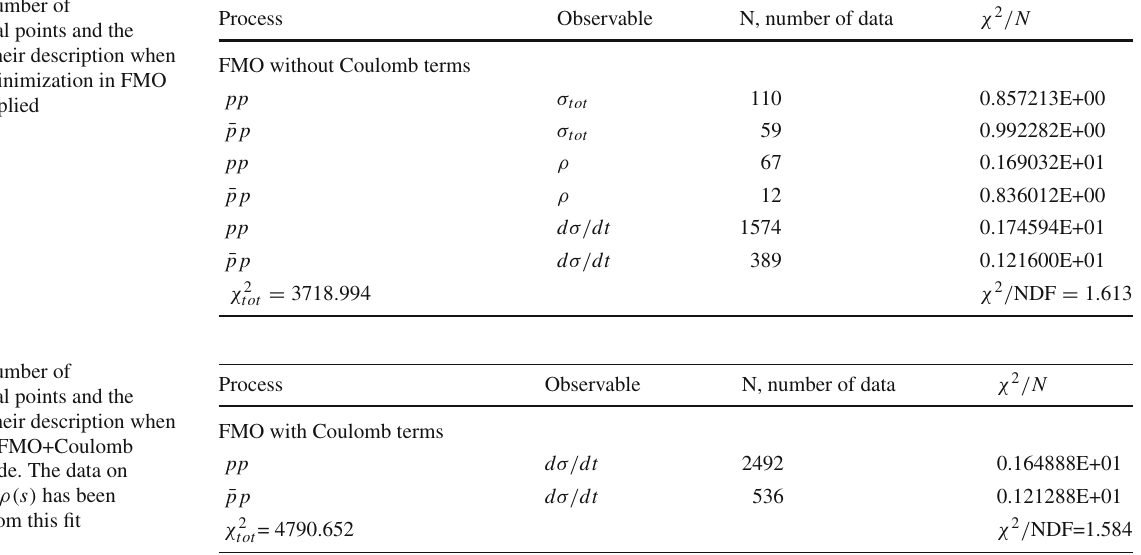
experimental points and the quality of their description when the usual minimization in FMO model is applied